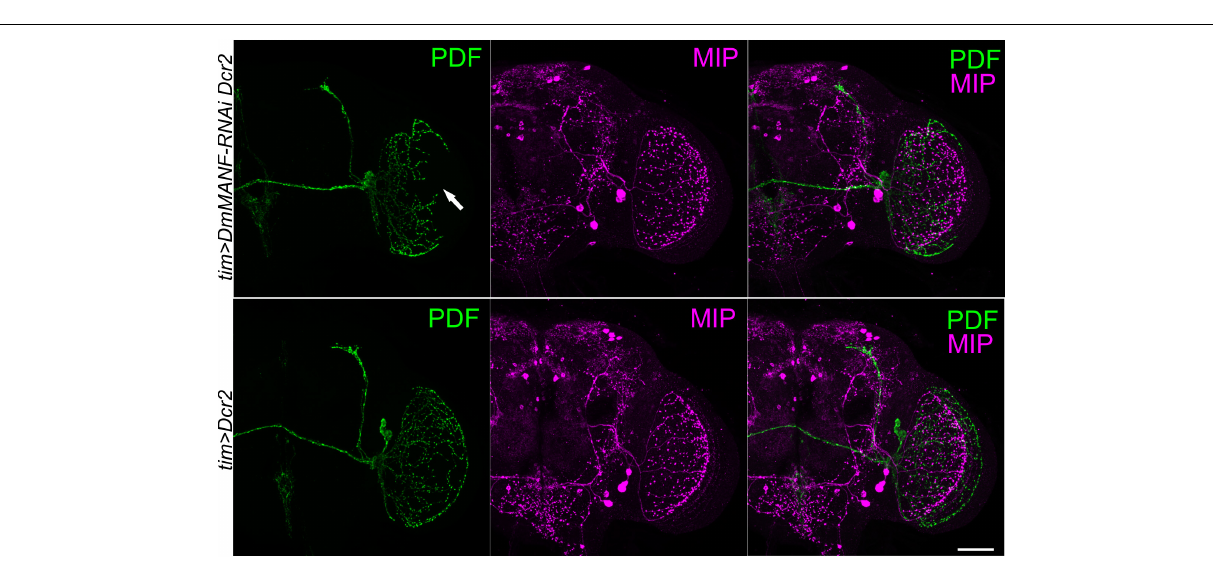
oscillations either in the whole head, or in the PDF-positive cells under both LD and DD